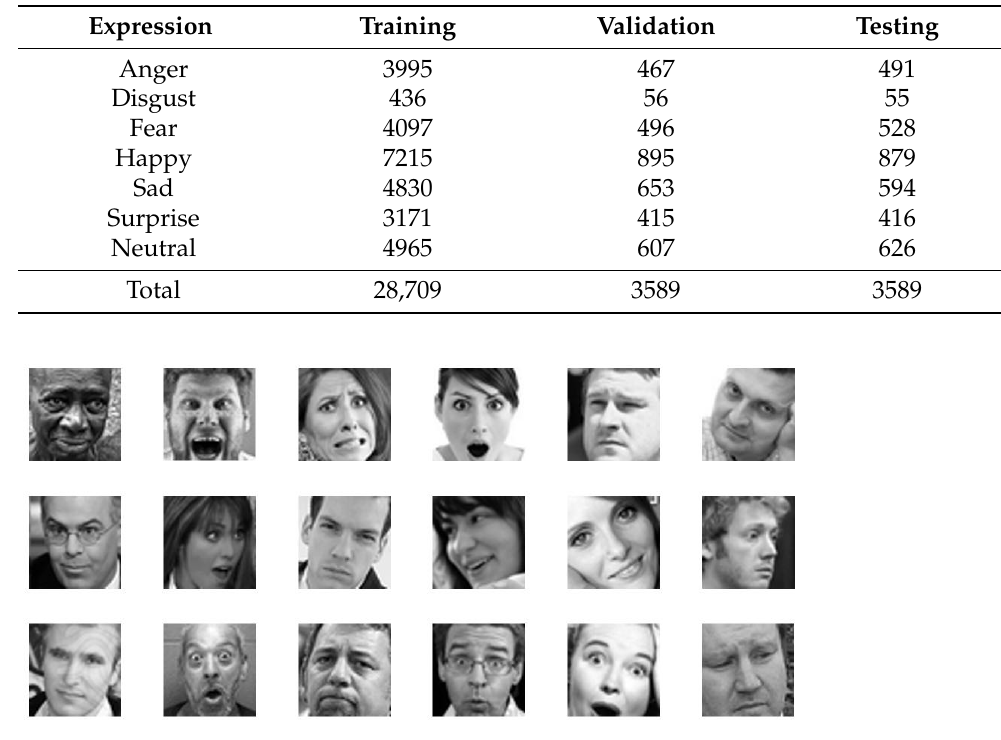
Figure 5. Some examples of images contained in the FER-2013